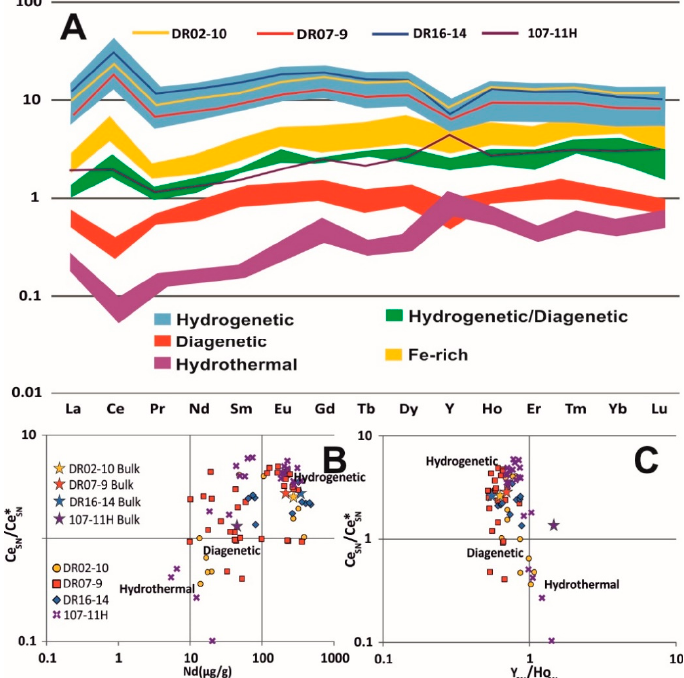
Figure 9. ( A ) PAAS [74] normalized REY of bulk (continuous lines) and spot LA-ICP-MS analysis (colored regions). ( B , C ) binary diagram REYs Ce SN /Ce SN * ratio compared with Nd and Y SN /Ho SN ratio [3] to differentiate genetic processes for bulk (stars) and spot analyses.